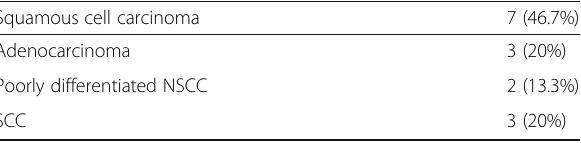
The total number of cases with positive biopsies for malignancy was 15 NSCLC non-small cell lung cancer, SCLC small cell lung